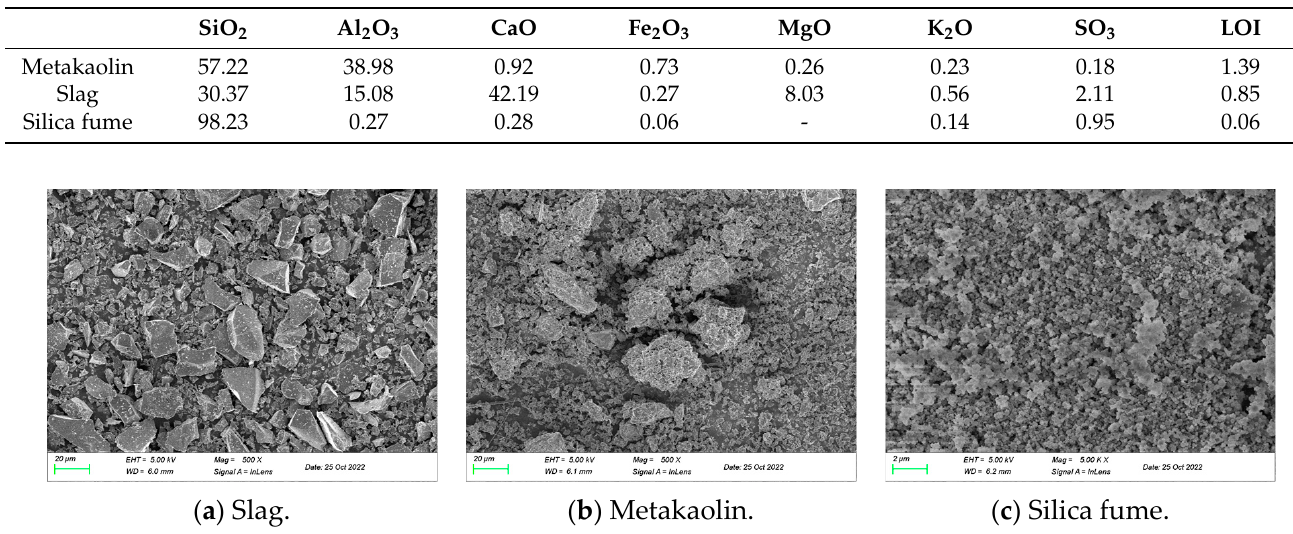
Figure 1. SEM images of raw materials of ( a ) slag, ( b ) metakaolin, and ( c ) silica fume. Table 1. Chemical compositions (wt.%) and loss on ignition (LOI) of the precursors.